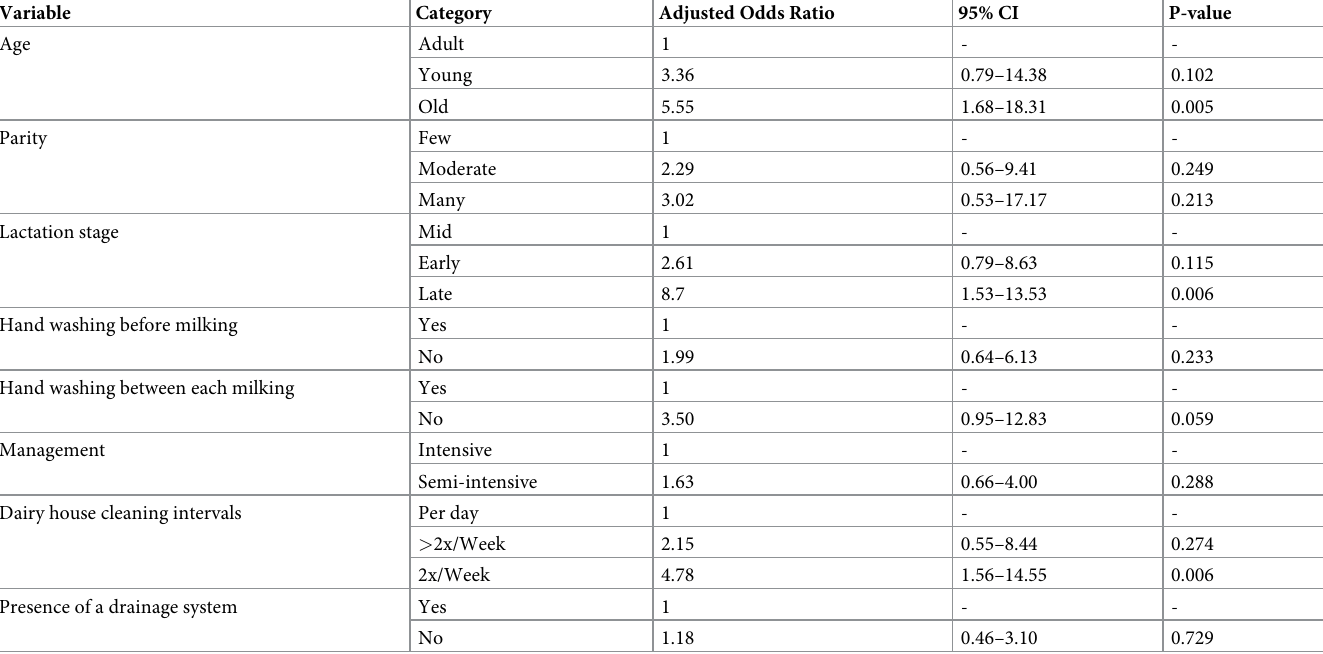
Table 6. Results of multivariable logistic regression analysis of factors associated with the contamination of the milk with S . aureus in the study area. Variable